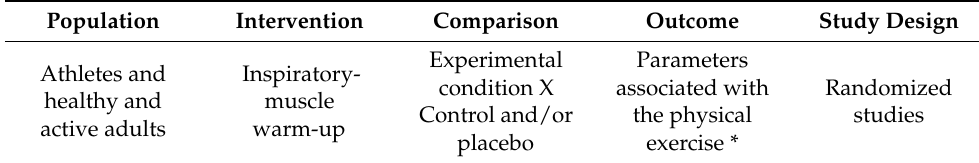
Experimental Parameters Inspiratory- condition X associated with Randomized muscle Control and/or the physical warm-up placebo exercise *